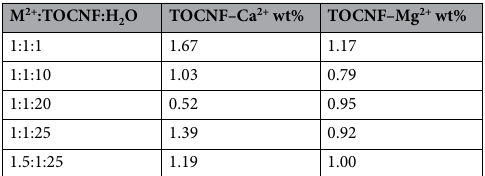
Table 2. Solid contents of 3D printed TOCNF–Ca 2+ and TOCNF–Mg 2+ hydrogels at various ratios